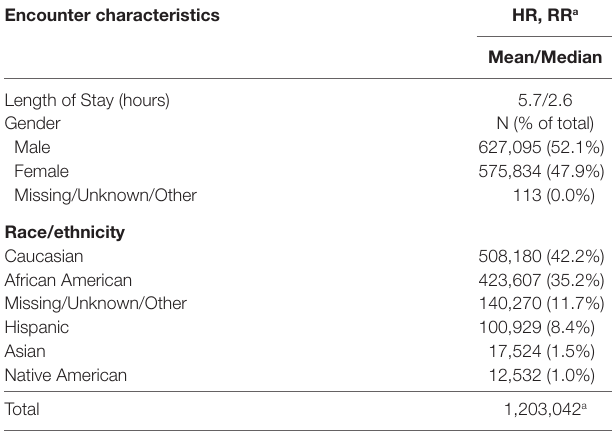
TaBle 2 | Contributing encounters: patient demographics and length of stay.